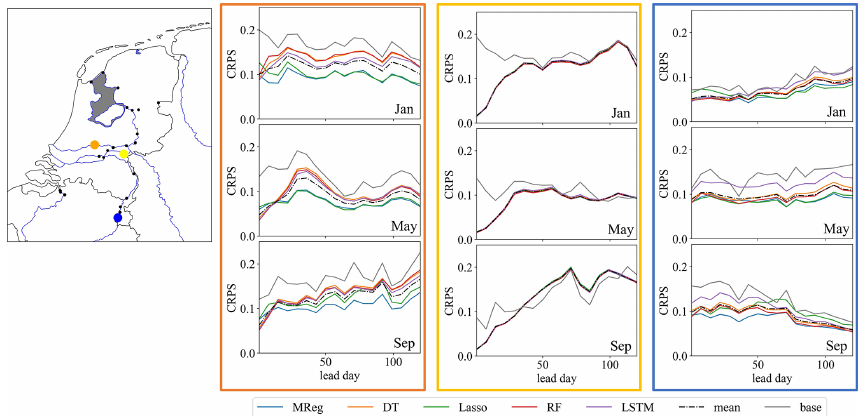
Figure B2. Overview of weekly CRPS scores for the months of January, May, and September. Different ML model scores, the average of the ML model score (dashed line), and climatological reference (grey) are shown for three surface water level stations along the main river networks – Hagenstein Boven (orange), Nijmegen Haven (yellow), and Borgharen Julianakanaal (blue). Maps were created using the Python package Cartopy (Elson et al., 2022), which uses basemap data made with Natural Earth and © OpenStreetMap contributors 2022. Distributed under the Open Data Commons Open Database License (ODbL) v1.0.